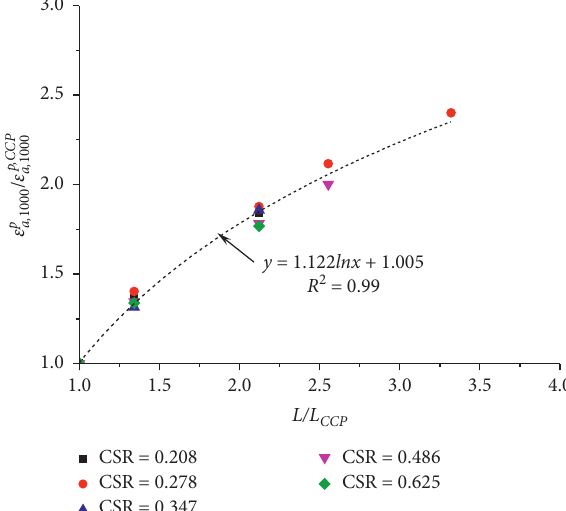
Figure 10: Normalized permanent axial strain after 1000 cycles versus the normalized length of stress